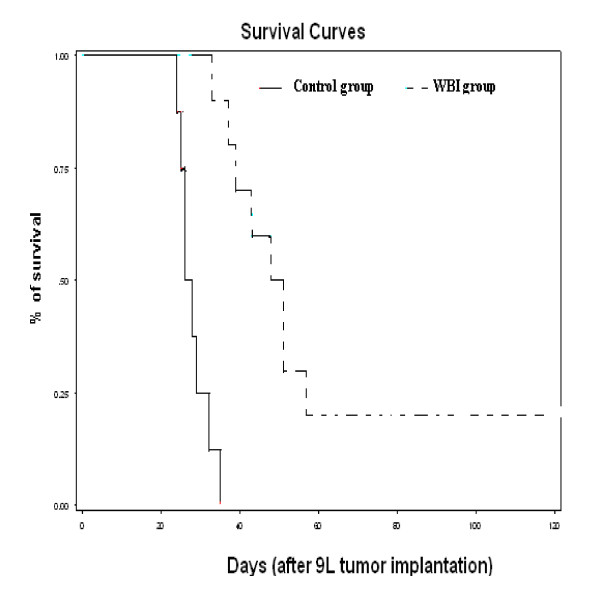
Survival curves depending of each group of treatment. Survival times (days) after tumor implantation have been plotted for "untreated animals" (Group A) and "WBI (3 fractions of 6 Gy)" animals (group B).